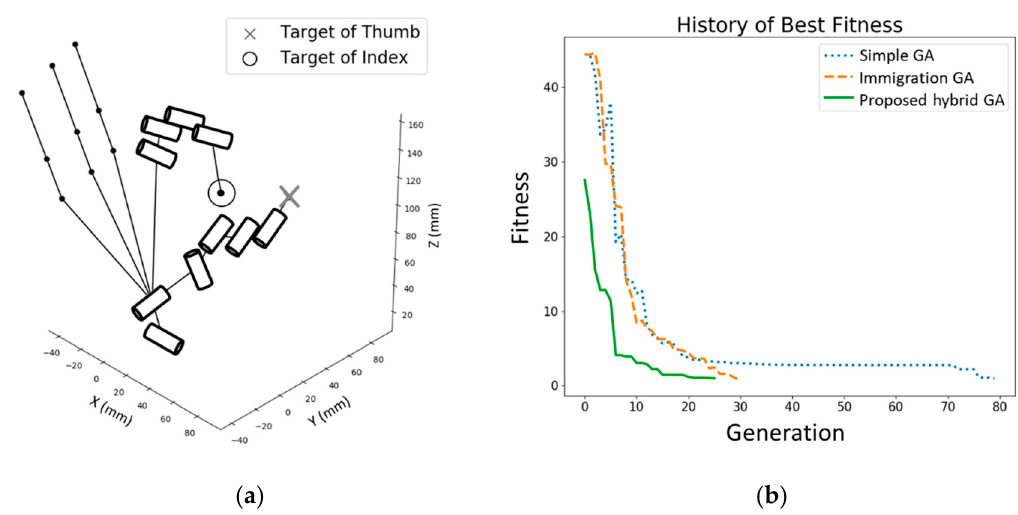
Figure 6. ( a ) Schematic illustration showing the solution resulting from an appropriate motion command and ( b ) the corresponding fitness performance of the illustrated case #1.